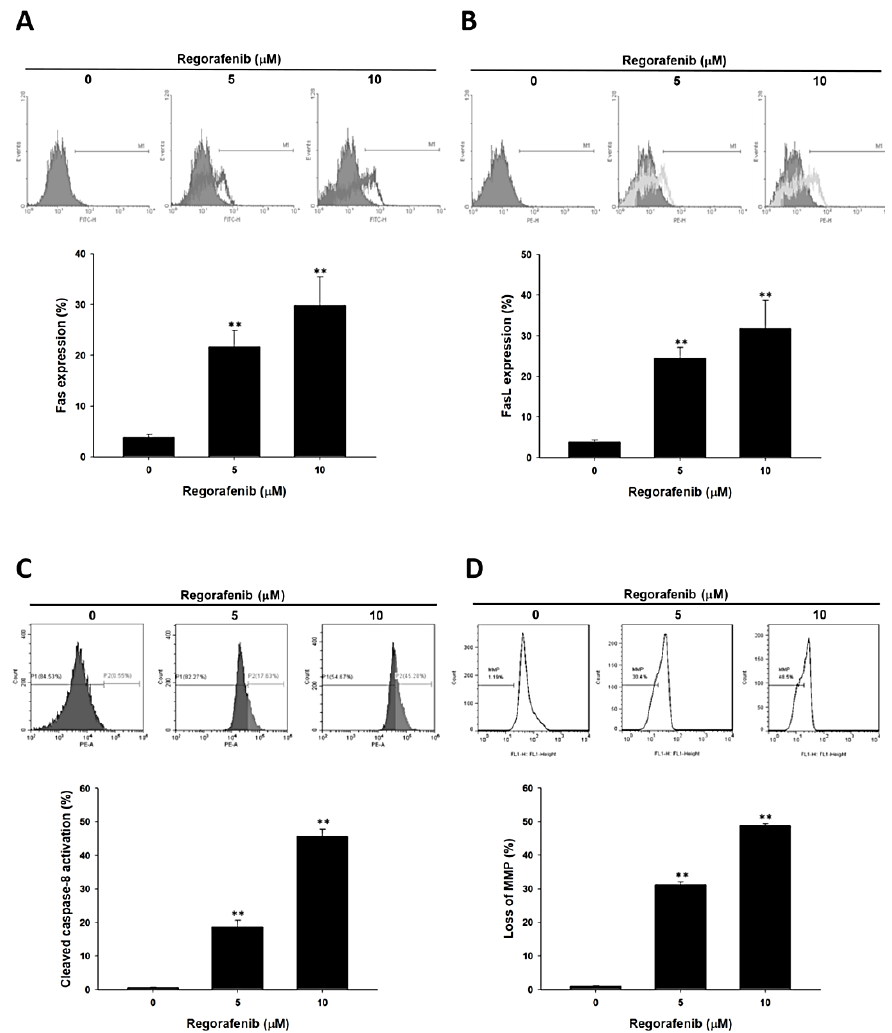
Figure 3. The death receptor dependent and mitochondria dependent apoptosis were activated by regorafenib. U-2 OS cells was treated with 0, 5, 10 µM of regorafenib for 48 h. The activation of ( A ) FAS, ( B ) FASL, and ( C ) cleaved caspase-8 were all detected by flow cytometry. ( D ) Mitochondria membrane potential was stained by DiOC 6 and also assayed by flow cytometry. ** p < 0.01 vs. 0 µM of regorafenib.